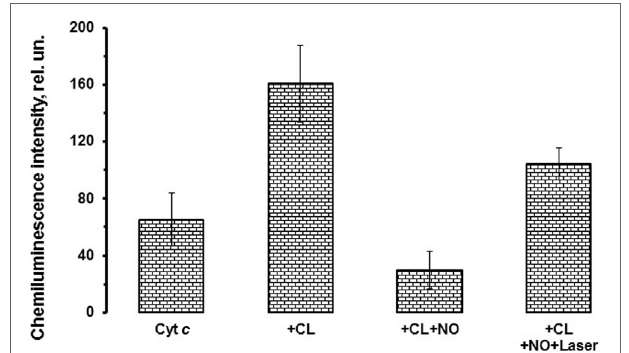
FigURe 3 | Effects of nitric oxide (NO) and laser radiation on cytochrome c peroxidase activity. The cytochrome c –cardiolipin (CL) nitrosyl complexes as well as cytochrome c nitrosyl complexes produced in the absence of CL possess photosensitivity and can be photolyzed upon irradiation with low power laser radiation. This figure shows the histogram depicting the cytochrome c peroxidase activity in the presence or absence of NO and laser radiation. Sample content: cytochrome c (10 μM) (most left column, marked as “Cyt c ”); same as previous sample, but CL–phosphatidylcholine liposomes (1:1, 0.2 mM) were added (second from the left column, marked as “ + CL”); same as previous sample, but NO (0.1 mM) was added (third from the left column, marked as “ + CL + NO”); same as previous sample, but He–Cd laser (442 nm) irradiation (20 mW, 15 min) was applied (most right column, marked as “ + CL + NO + Laser”). All samples were prepared in 10 mM phosphate buffer (pH 7.4). Incubation time was 10 min. H 2 O 2 (100 µM) and luminol (500 µM) were added immediately before measurements.